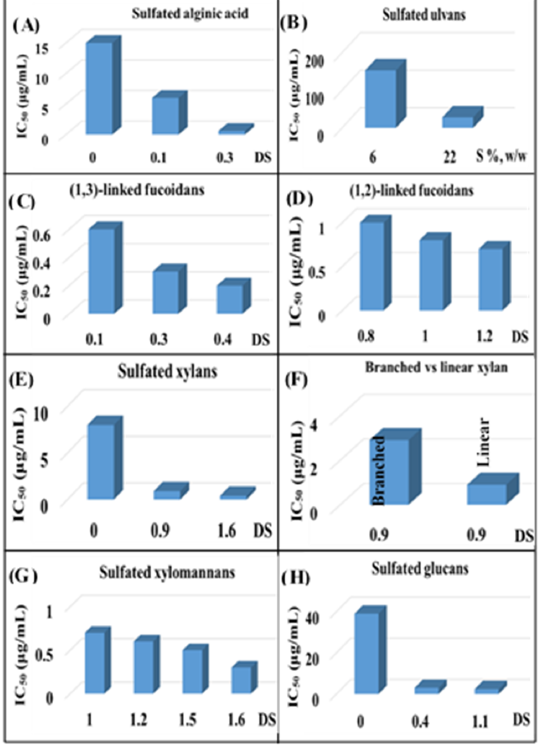
Figure 3. Comparison of antiviral activity of sulfated ( A ) alginic acids against HSV-1 [74,76], ( B ) ulvans against HSV-1 [45], ( C ) fucoidans against HSV-1 [77], ( D ) fucoidans against HSV-1 [73], ( E ) xylans against HSV-1 [97], ( F ) linear and branched β -1,4-xylans having same degrees of sulfation against HSV-1 [46,97], ( G ) xylomannans against HSV-1 [98] and ( H ) glucans against HCMV and HSV-1 [275] having different degrees of sulfation. Antiviral activity was performed by plaque reduction assay in RC-37 cells (African green monkey kidney cells) ( A , C ), in HEp-2 cells (human larynx epithelial cells carcinoma, ATCC CCL-23) ( B ), in Vero cells ( D – G ) and by GFP-based replication assay in primary human fibroblasts ( H